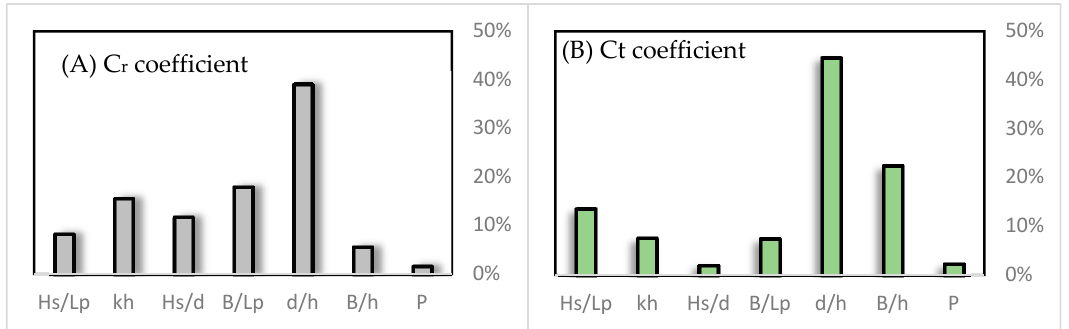
Figure 8. Parameter contribution ratio for ( A ) Cr coefficient ( B ) Ct Coefficient.